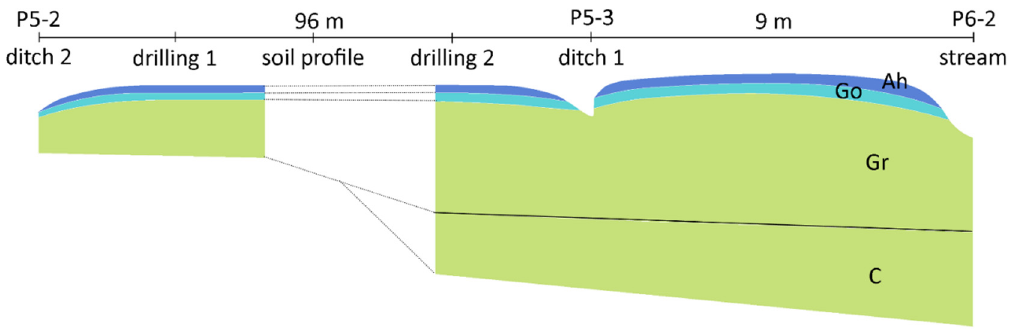
Figure 3. Geometry of the model domain and implemented soil layers. The soil body was divided into three different horizons (Ah, Go, and Gr/C).